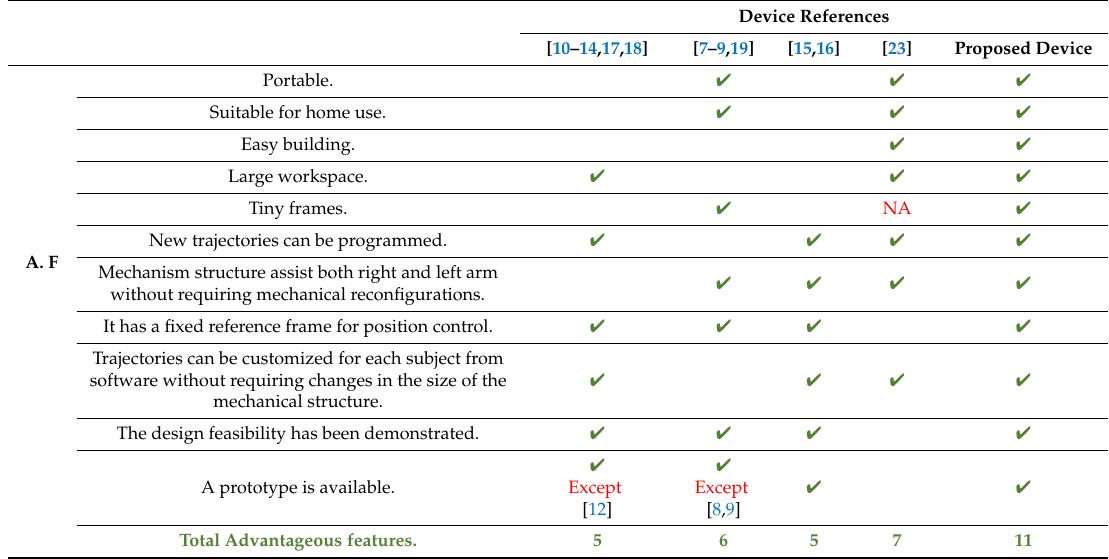
Table 1. Summary of advantageous features (A.F.) and disadvantageous features (D.F.) of the referenced